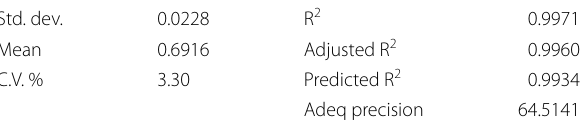
Table 6 Key results from ANOVA (Tensile) Std. dev.